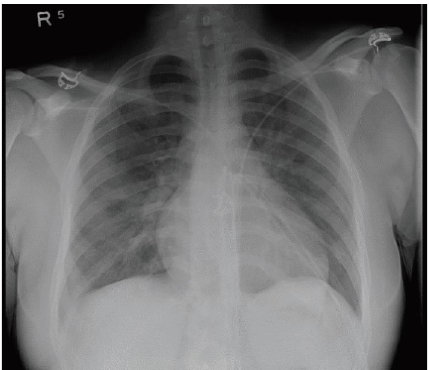
Figure 1: Antero-posterior (AP) view chest X-ray showing bilateral